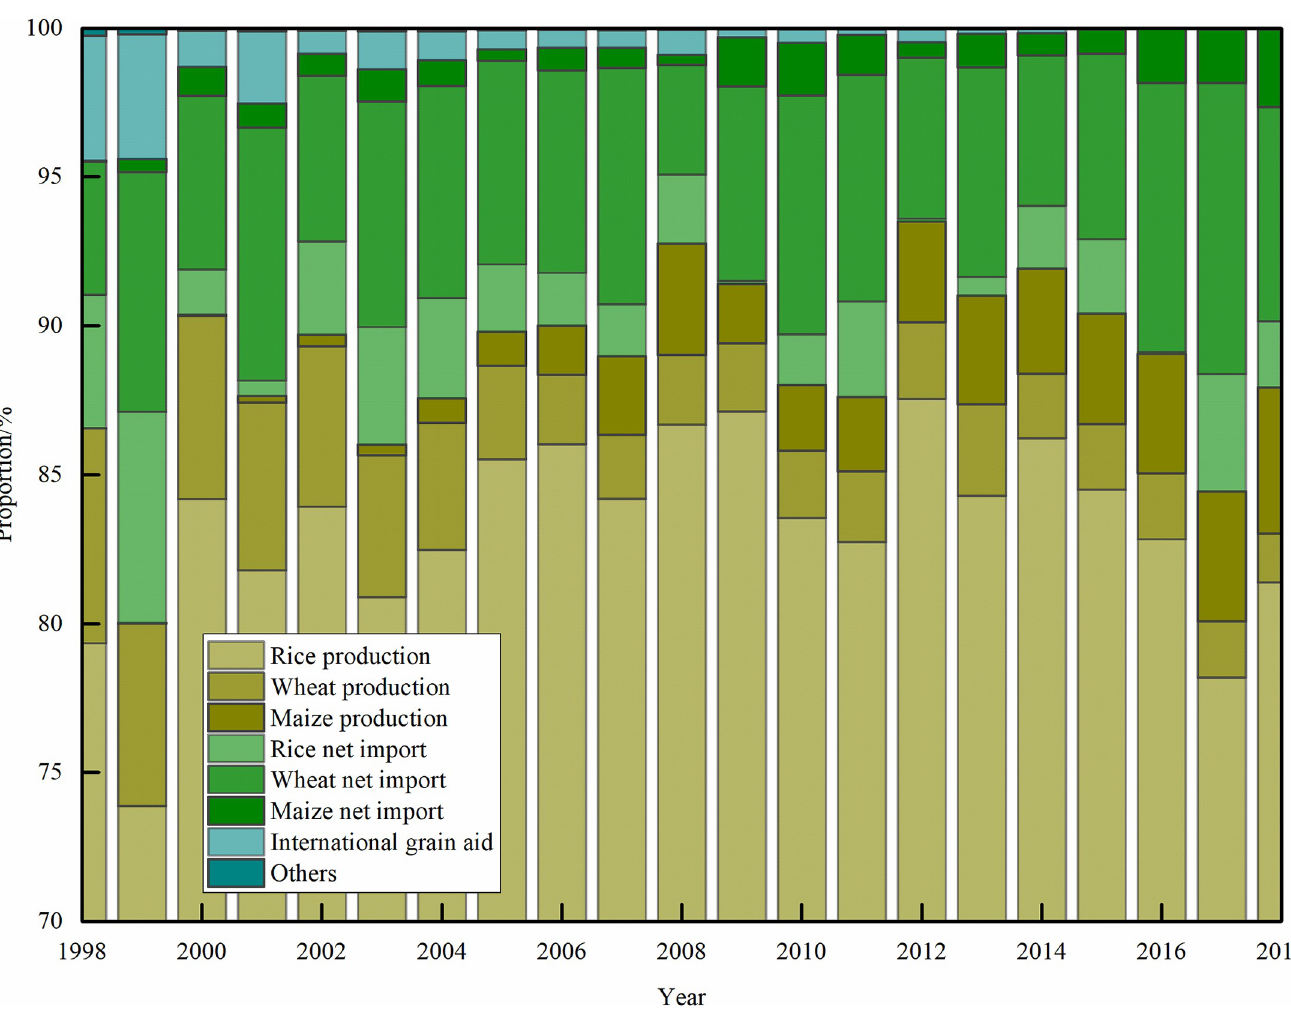
Fig 4. Supply structure of grain products in Bangladesh from 1998 to 2018.